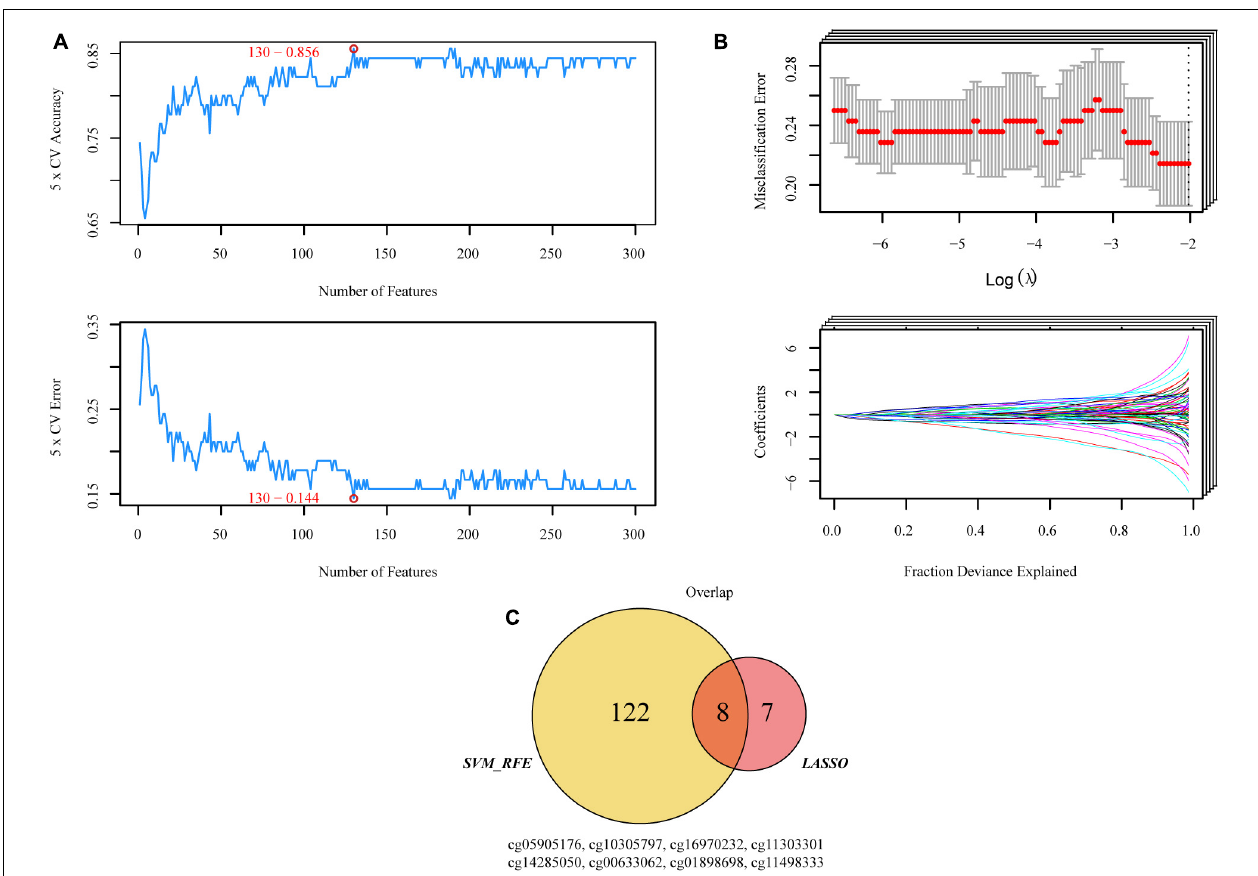
FIGURE 2 | Two algorithms were used for selecting the candidate CpGs. (A) The number of features with the optimal accuracy and the lowest error rate under fivefold cross validation in SVM-RFE. (B) LASSO algorithms in the discovery cohort. (C) Incorporation of CpGs methylation that were selected from the LASSO and SVM-RFE algorithms in the discovery cohort. SVM-RFE, support vector machine-recursive feature elimination; LASSO, least absolute shrinkage and selector